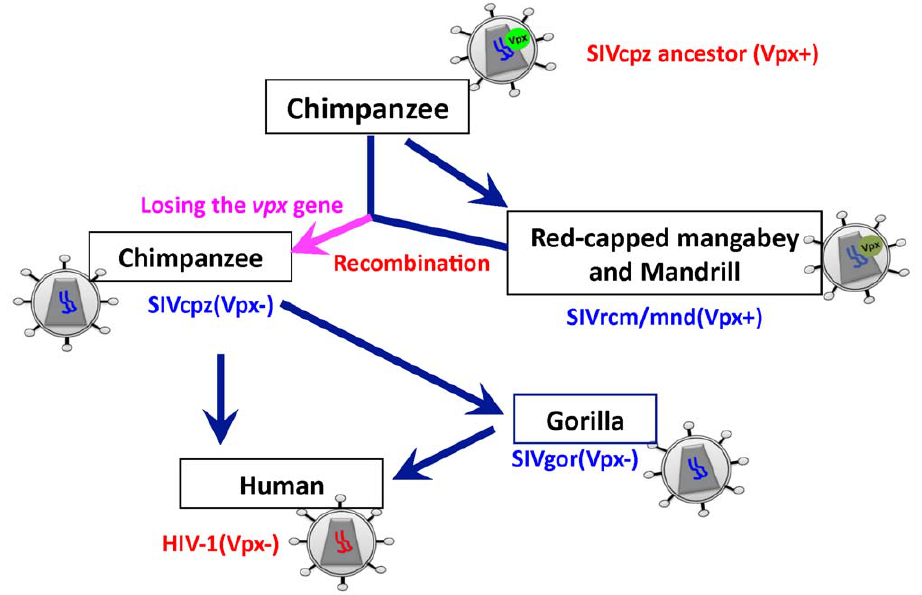
Figure 5. Schematic representation of evolutionary history and loss of the vpx gene in certain SIVs and HIV-1. The ancestor virus might have encoded functional Vpx proteins that could degrade SAMHD1. It was likely transmitted to red-capped mangabeys and mandrills prior to the loss of vpx gene and evolved into SIVrcm/mnd among the two primate species. Because the ancestral host state of SIVcpz, SIVrcm, SIBmnd, SIVgor and HIV-1 most likely is SIVcpz in the gag and pol gene regions (Fig. 4, and Fig. S5A), but more likely is SIVrcm or SIVmnd in the env region (Fig. S5B), implying that the loss of vpx in SIVcpz was a result from positive selection of SIV recombination and viral fitness. The vpx gene of SIVcpz was likely lost around 3643 to 2969 years ago, resulting in the emergence of SIVcpz(Vpx 2 ). SIVcpz(Vpx 2 ) was later transmitted to humans and gorillas, evolving into HIV-1 and SIVgor(Vpx 2 ), respectively. The pink arrow indicates the occurrence of vpx gene loss.